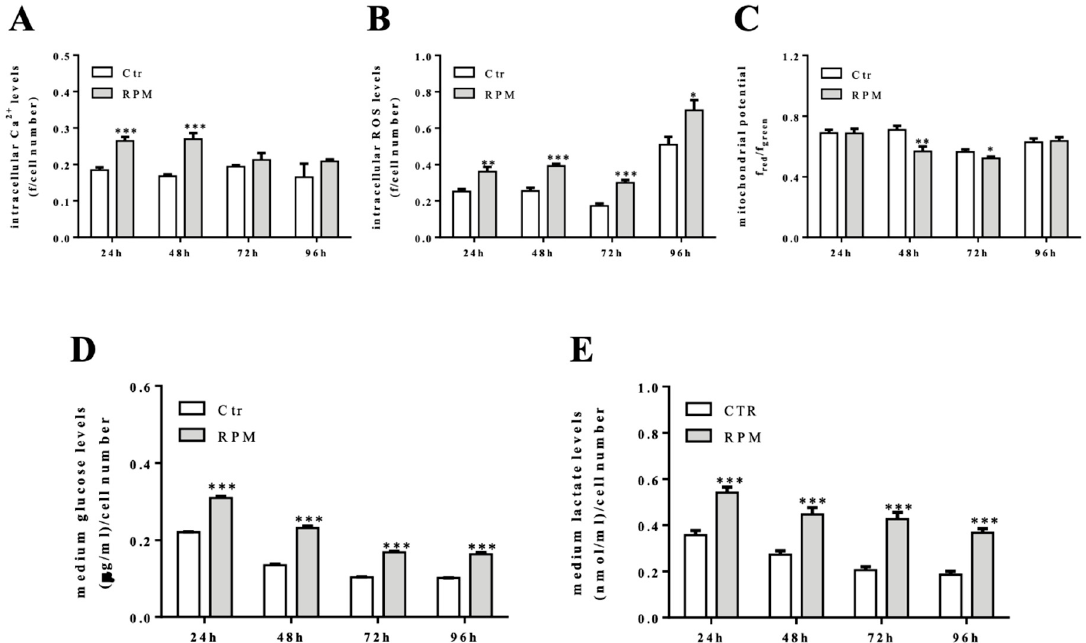
Figure 3. Intracellular and metabolic responses of MC3TE-E1 cells to s-microgravity. ( A , B ) Intracellular Ca 2 + and reactive oxygen species (ROS) levels in live cells grown at 1 g (Ctr) or exposed to s-microgravity (RPM) at di ff erent exposure times (24–96 h) and expressed as a ratio between fluorescence emission ( f ) and the number of loaded cells at each time point. ( C ) Mitochondrial membrane potential values graphed as a ratio between red and green fluorescence ( f ) at each time point. ( D , E ) Glucose and lactate levels measured in the growth medium of the Ctr and RPM-exposed cells. The data in the graphs are presented as the means ± SEM from three independent experiments. * p < 0.05 , ** p < 0.01 , *** p < 0.001 vs. Ctr